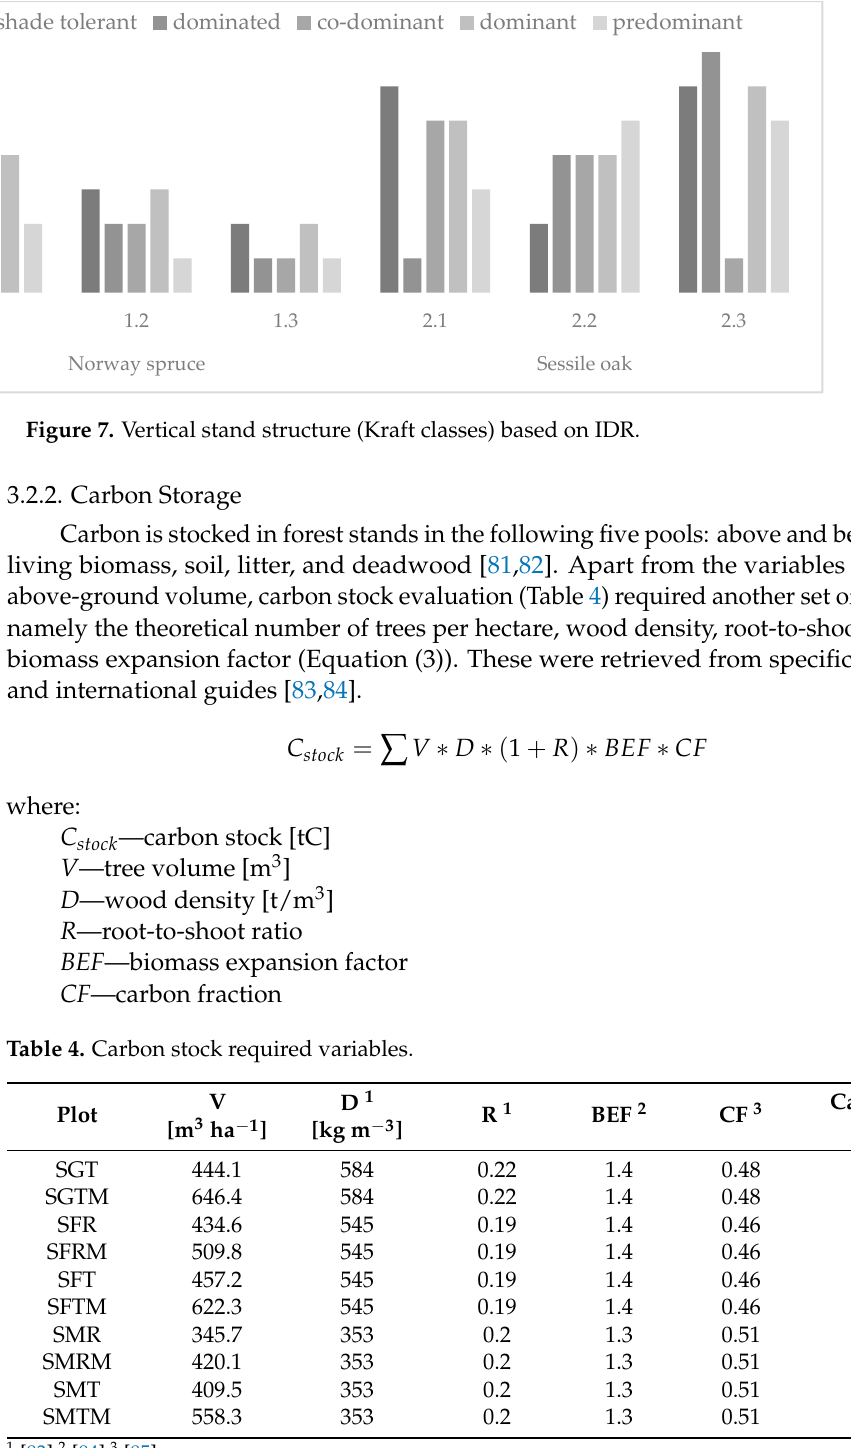
Figure 6. Clark-Evans nearest neighbors index and uniform angle index.